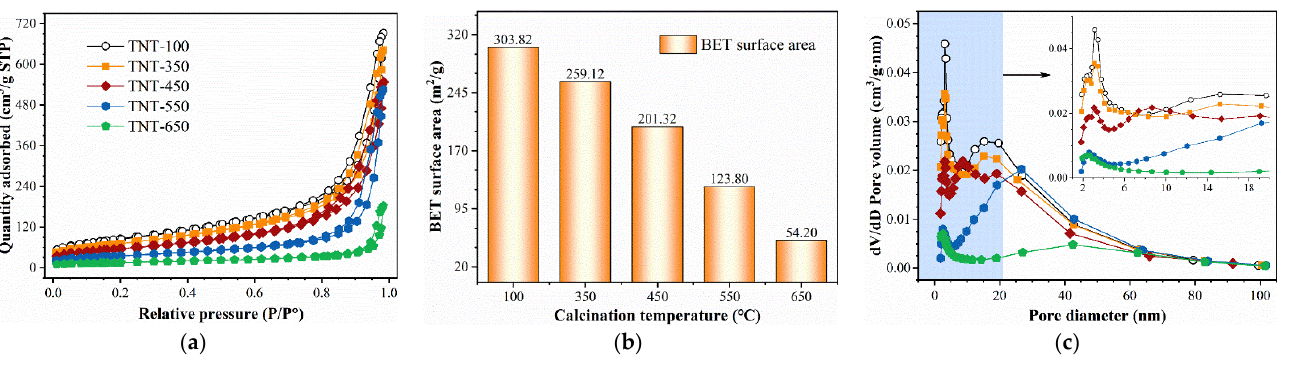
Figure 3. Variations of ( a ) N 2 adsorption-desorption isotherm, ( b ) BET surface area, and ( c ) pore size distribution of the nanostructured photocatalysts calcined under different temperatures.